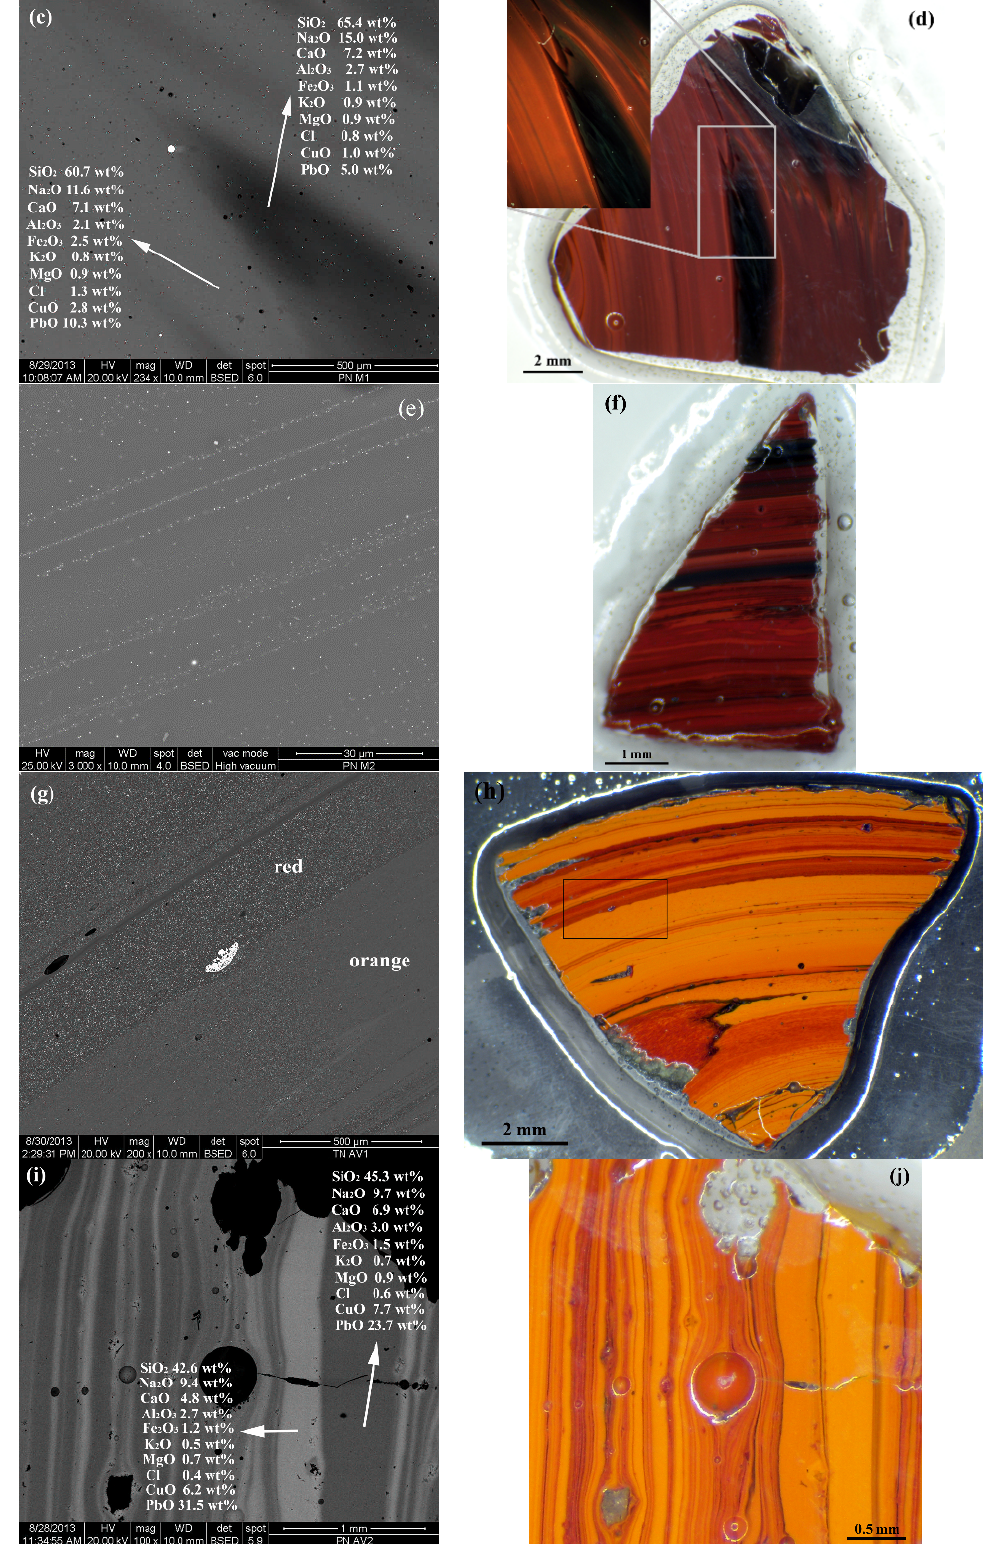
Figure 14. SEM-BSE ( a – c , e , g , i ) and OM ( d , f , h , j ) images of various micro-textures of red-banded tesserae: ( a ) TN M2: the banding is due to a variable concentration of iron, which is higher in brighter areas, and relative abundance of crystals; white inclusions are iron oxides. ( b ) TN M1: metallic copper crystals of micrometric and nanometric size are visible; the white rounded drop is a segregation of metallic